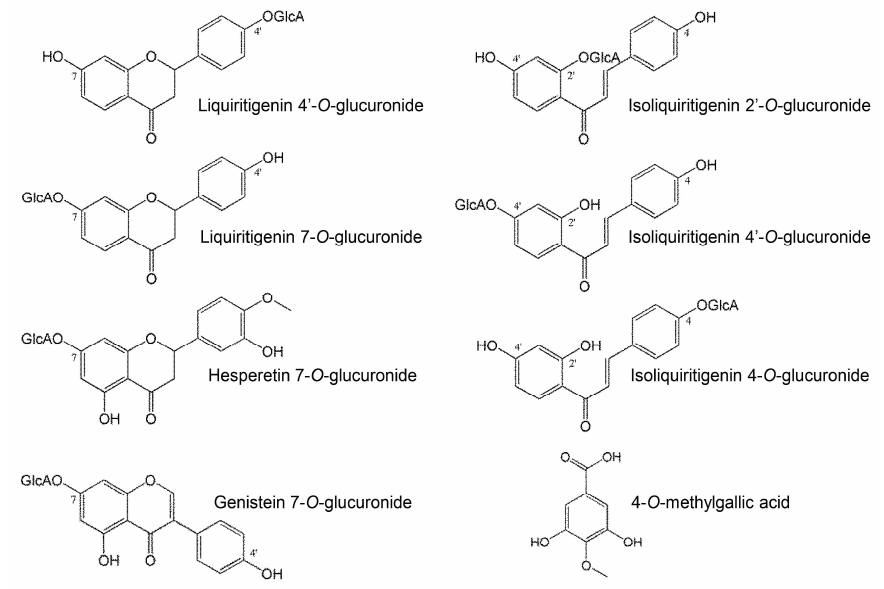
Figure 5. Chemical structures of metabolites appearing in